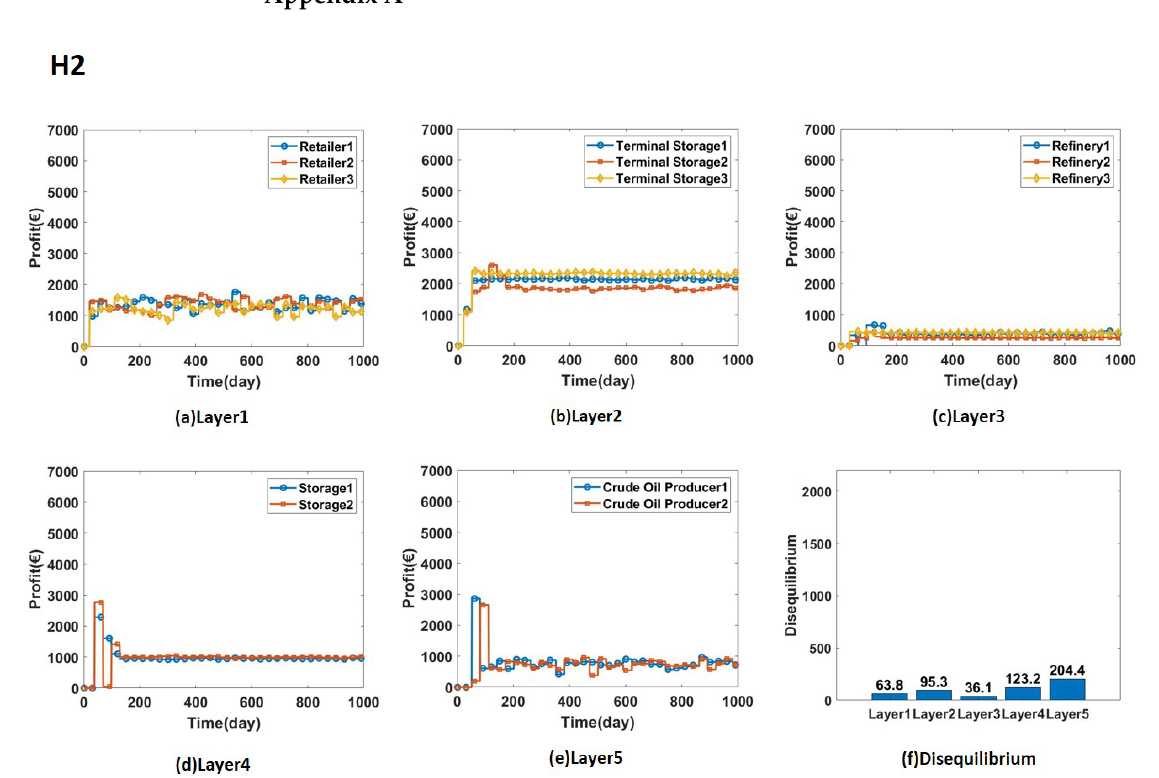
Figure A1. The profit and the disequilibrium of the profit for each layer considering variables of H 2 .